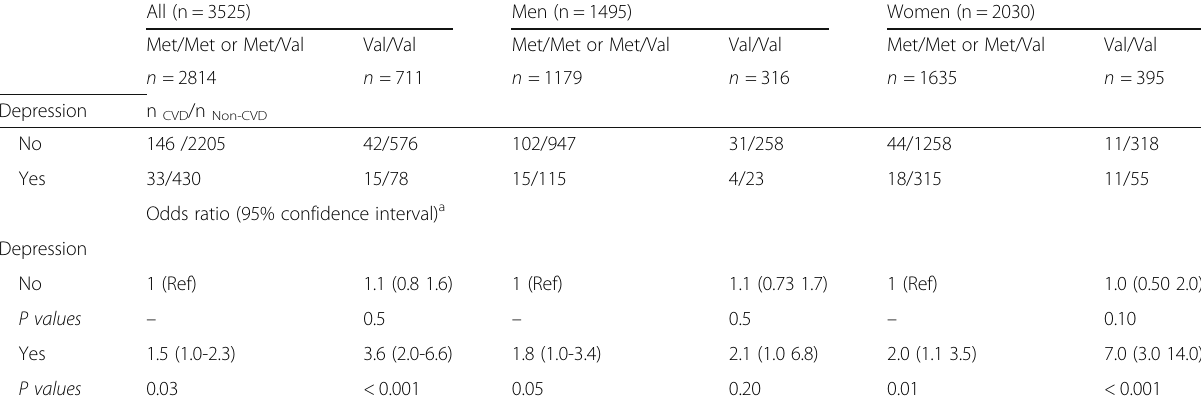
Table 3 Interaction between COMT Val 158 Met and depression for later cardiovascular disease (CVD), stratified by gender All (n =